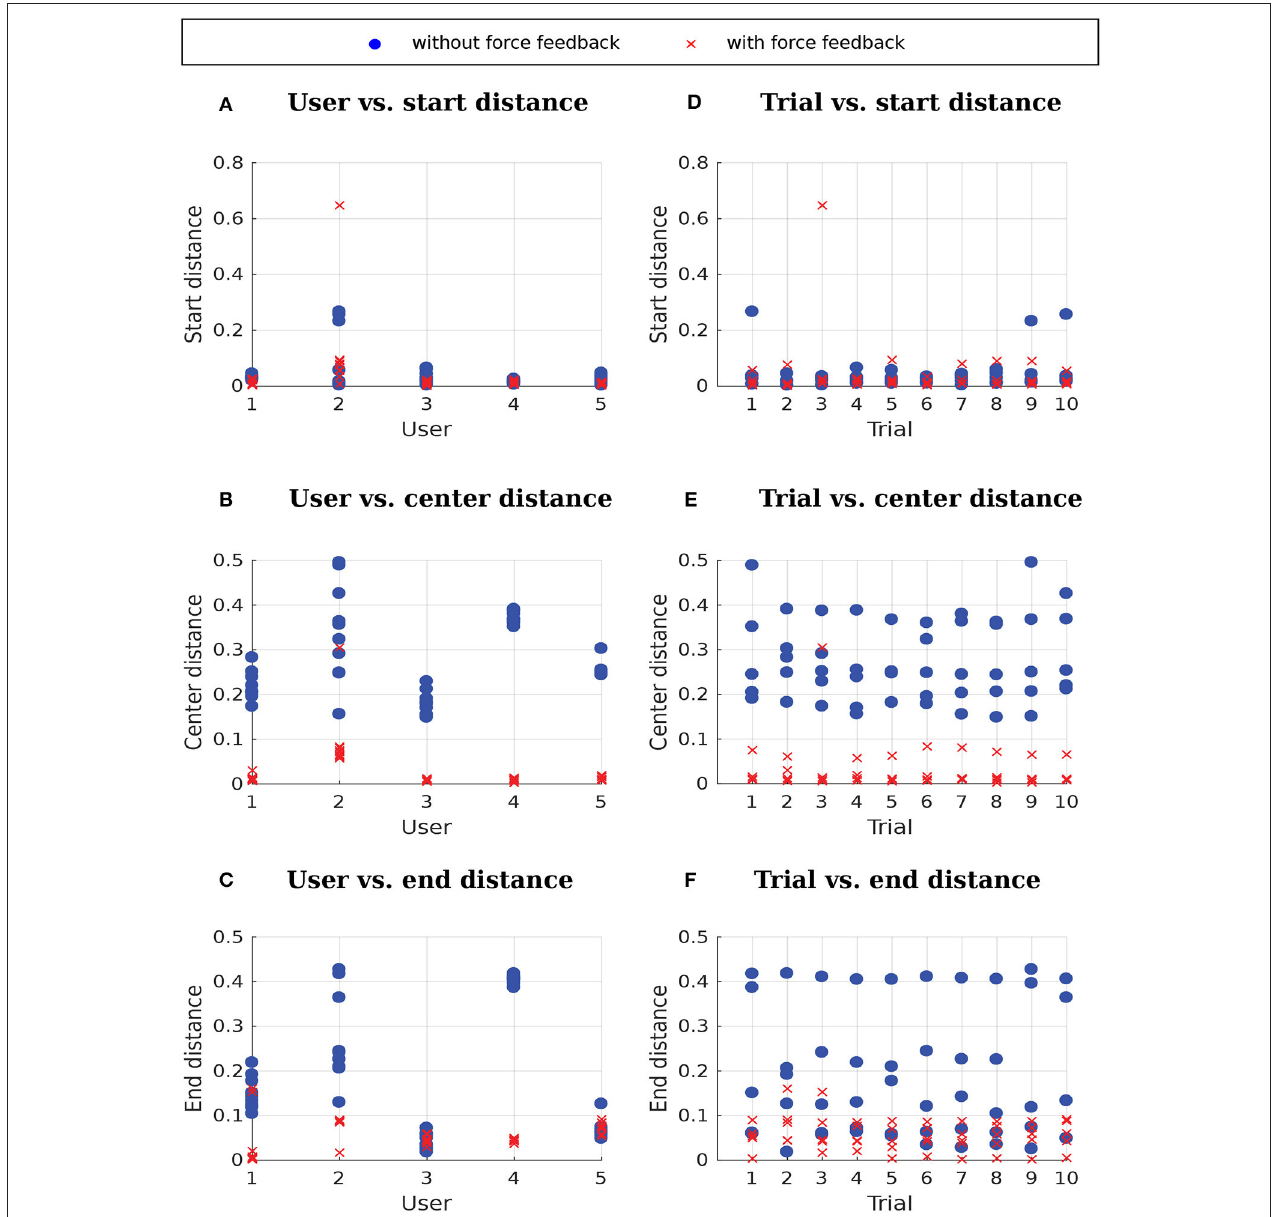
FIGURE 15 | Distances without force feedback and with force feedback. (A–C) User vs. distances, where each data point corresponds to a different trial. (D–F) Trial vs. distances, where each data point corresponds to a different user.